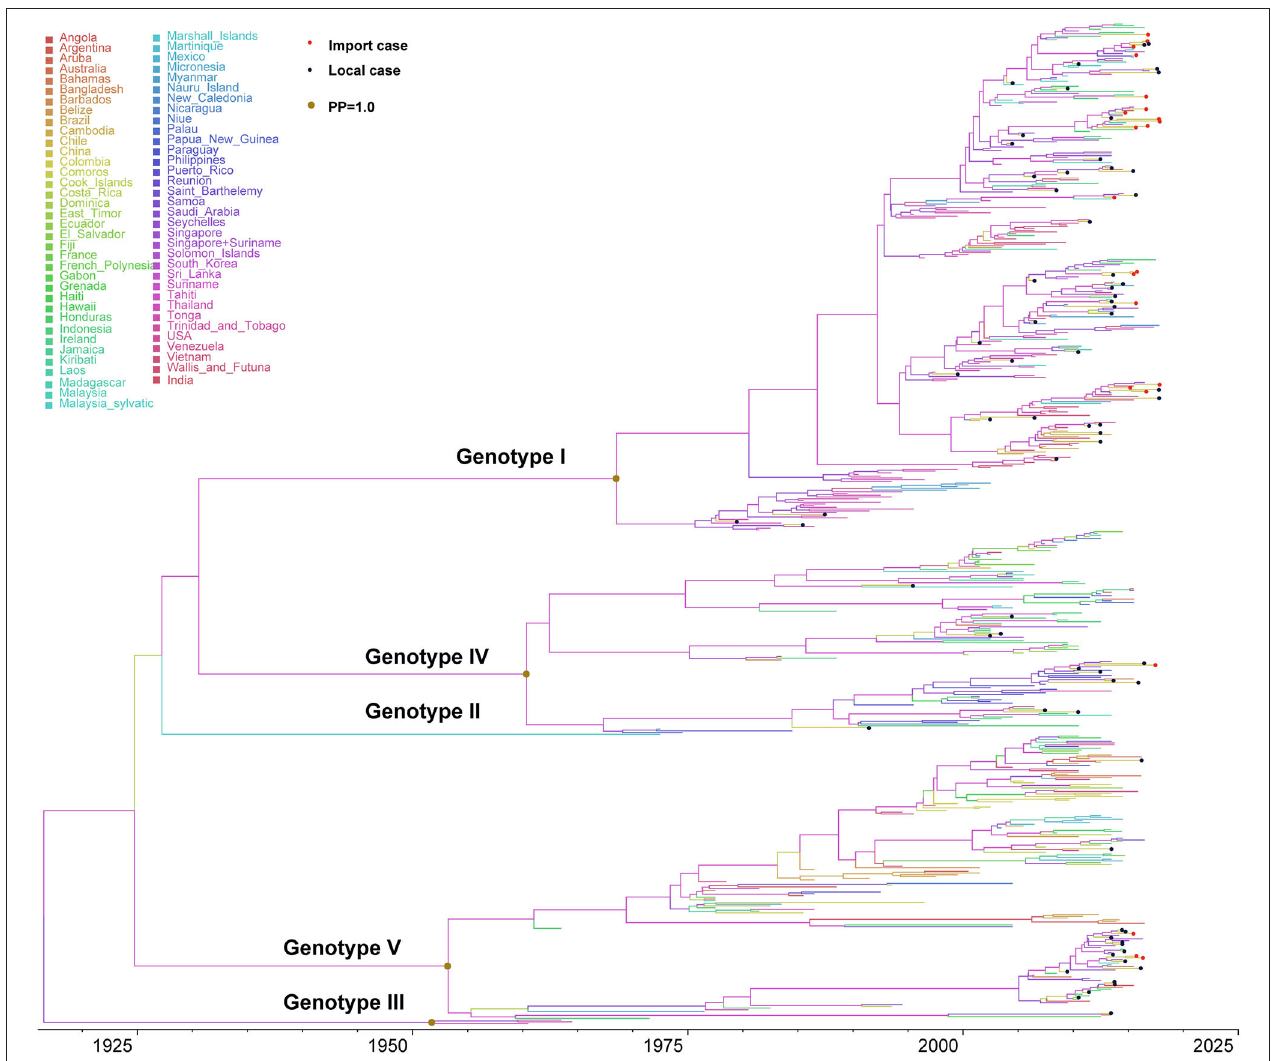
FIGURE 3 | Bayesian evolutionary tree of DENV 1. Source countries/regions of each strain and different genotypes of DENV 1 are presented by colors. Red dots represent imported cases, blue dots represent local cases, and brown dots are internal branch points with posterior probability =